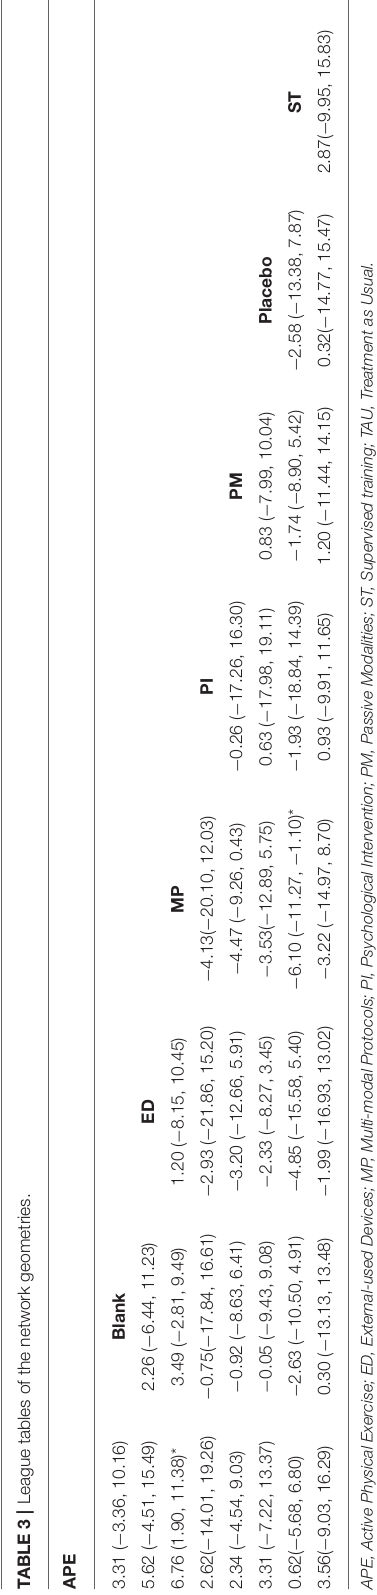
TABLE 2 | Random effect standard deviation and 95% confidence interval value of the agreement model and the inconsistency